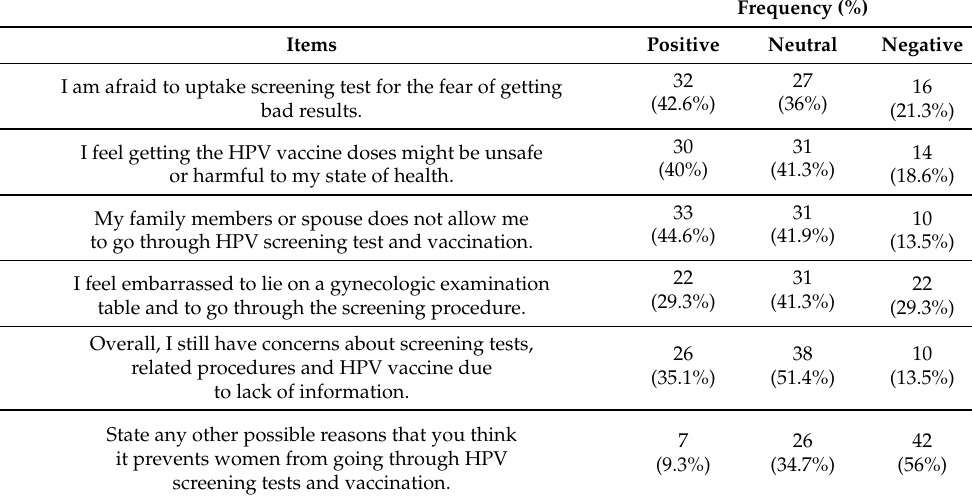
Table 3. Sentiment